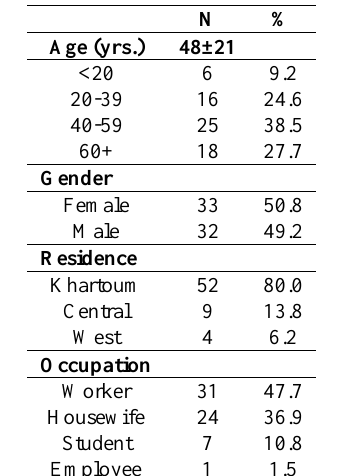
Figure 2: The CRP levels among severe malaria patients